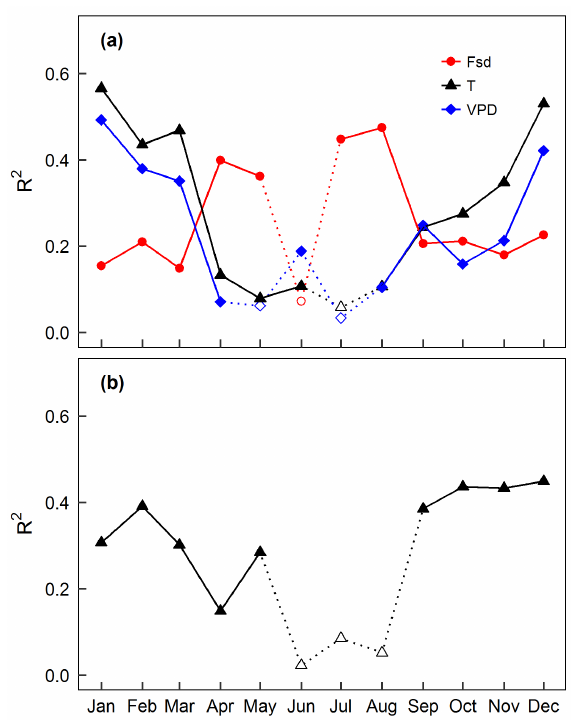
Figure 6. Seasonal variability in environmental controls of daytime and night-time NEE. Coefficients of determination ( R 2 ) of (a) the rectangular hyperbolic light-response curve (LRC) between daily means of midday NEE and incoming radiation ( F sd ; red lines and circles), linear fits between residuals of LRC and air temperature ( T a ; black lines and triangles) or vapour pressure deficit (VPD; blue lines and diamonds) and (b) the temperature-response function after Lloyd and Taylor (1994) between daily means of u ∗ -filtered night- time NEE and air temperature ( T a ; black lines and triangles) per month pooled over 3 years. Open symbols indicate non-significant R 2 values; data points per month for panel (a) from January to De-